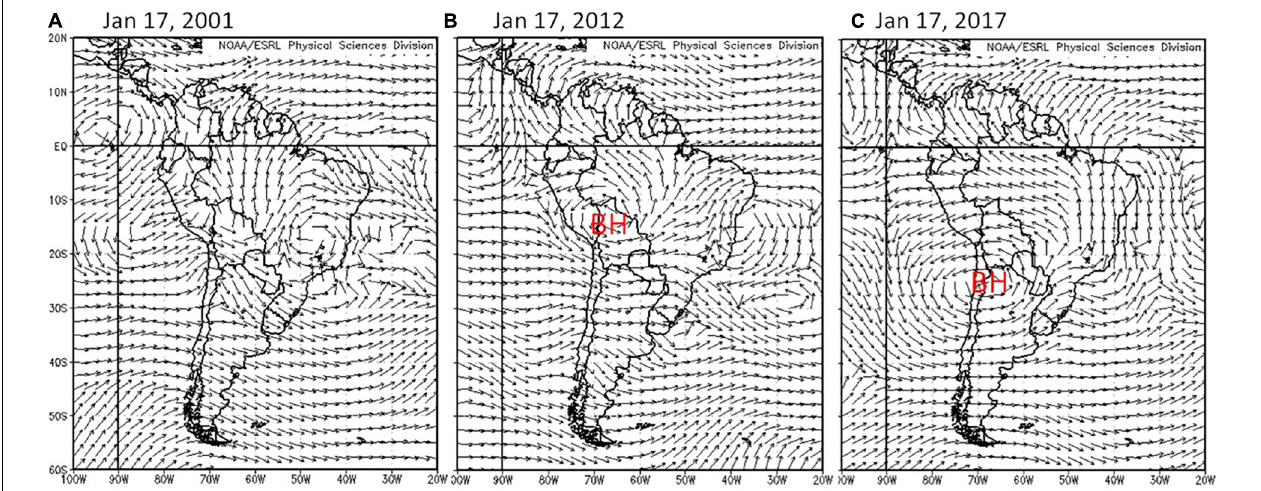
FIGURE 5 | 200 hPa winds for 3 days in austral summer depicting an absent Bolivian High (BH; A ), a Bolivian High near its climatological position (B) and an intense, broad Bolivian High centered well to the south of its mean position (C) . Wind data from NCEP-NCAR Reanalysis.